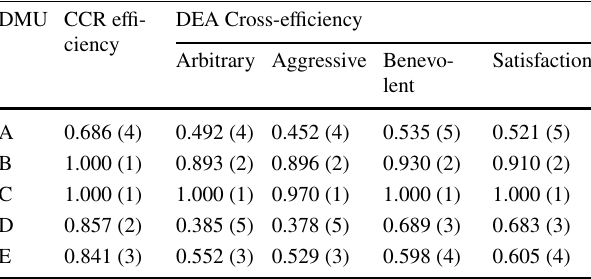
Table 8 CCR efficiency, cross-efficiency and ranking results